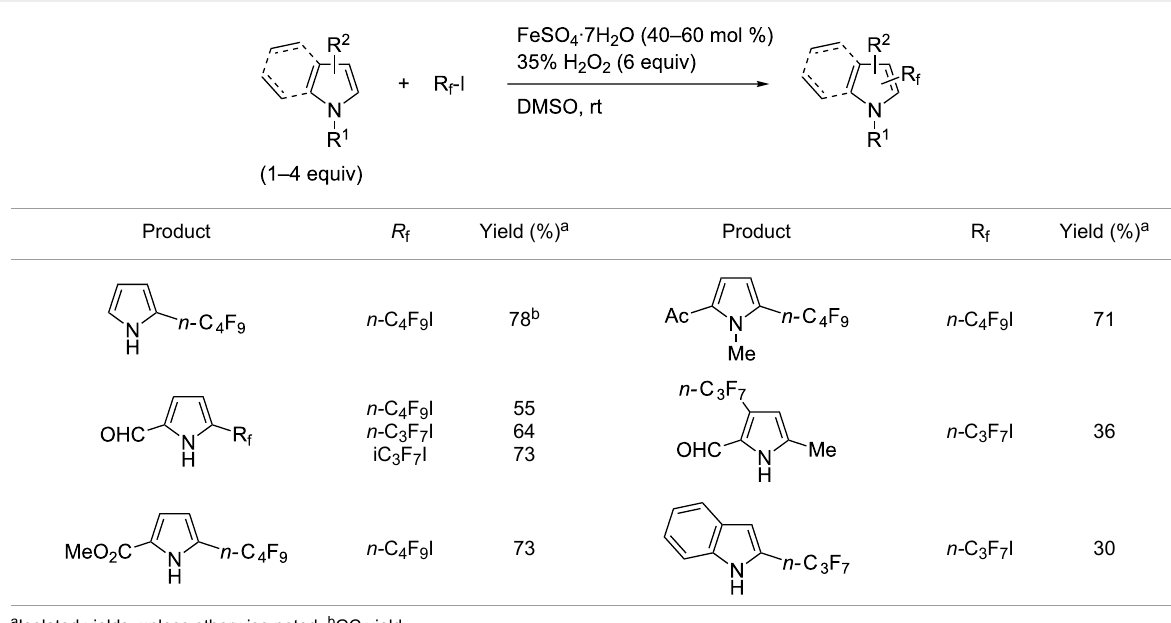
Table 37: Perfluoroalkylation of pyrroles employing Fenton’s reagent